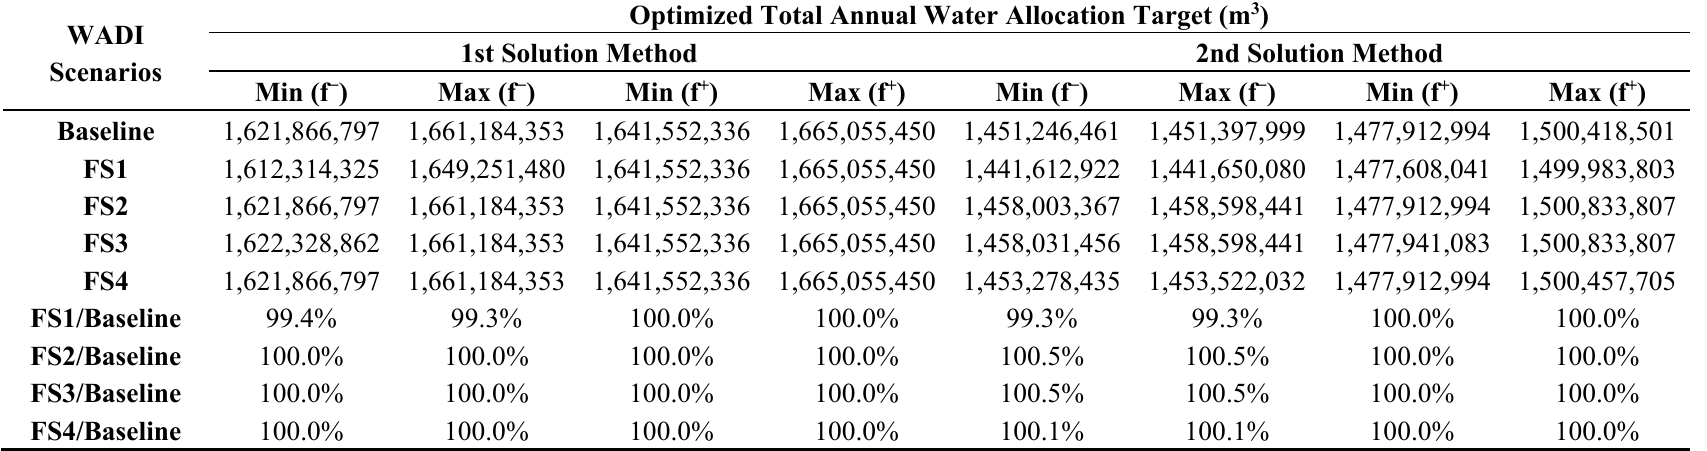
Table 22. Optimized total annual water allocation target of the four future scenarios as ratio of the baseline (%). WADI